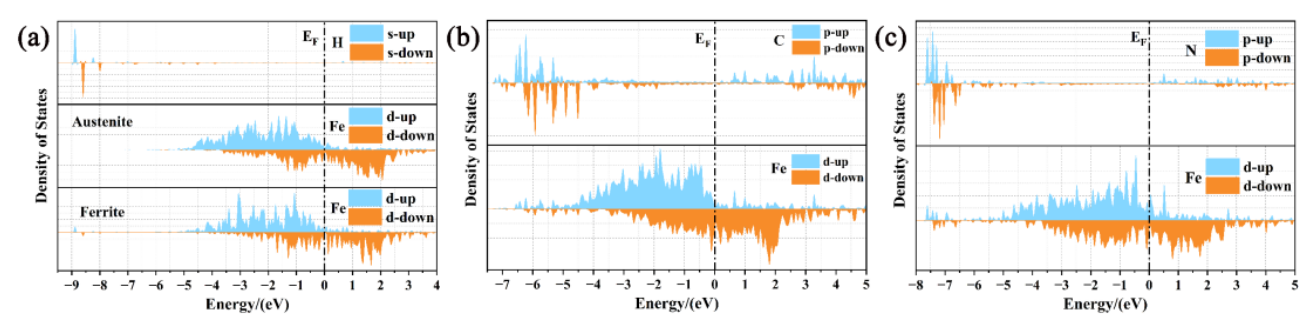
Table 1. Binding energy, cohesion energy, and enthalpy of formation for the single-atom model. E bind /(eV) E coh /(eV/Atom) E form /(eV/Atom) Pure homojunction − 29.4801 − 4.5601 0.3003 Homojunction with H − 29.2527 − 4.5486 0.2991 Homojunction with C − 32.3280 − 4.5686 0.3057 Homojunction with N − 32.4214 − 4.5585 0.2782